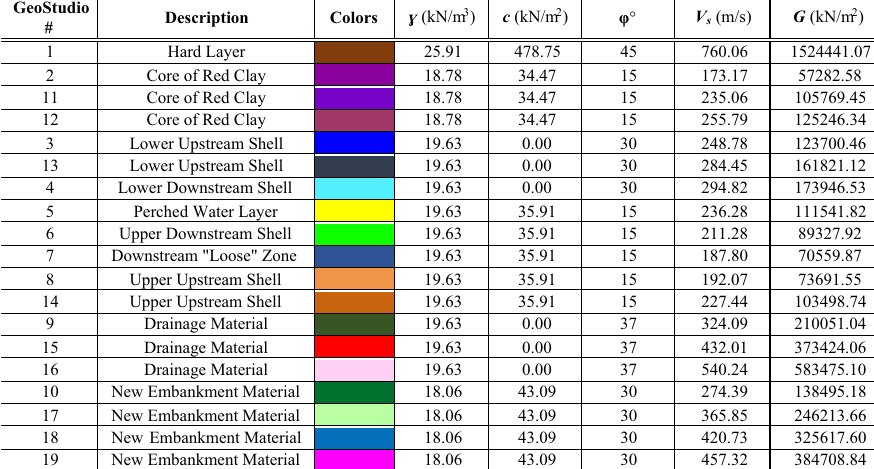
Table 1 P450s with chloroplast or mitochondiral targeting signals GeoStudio